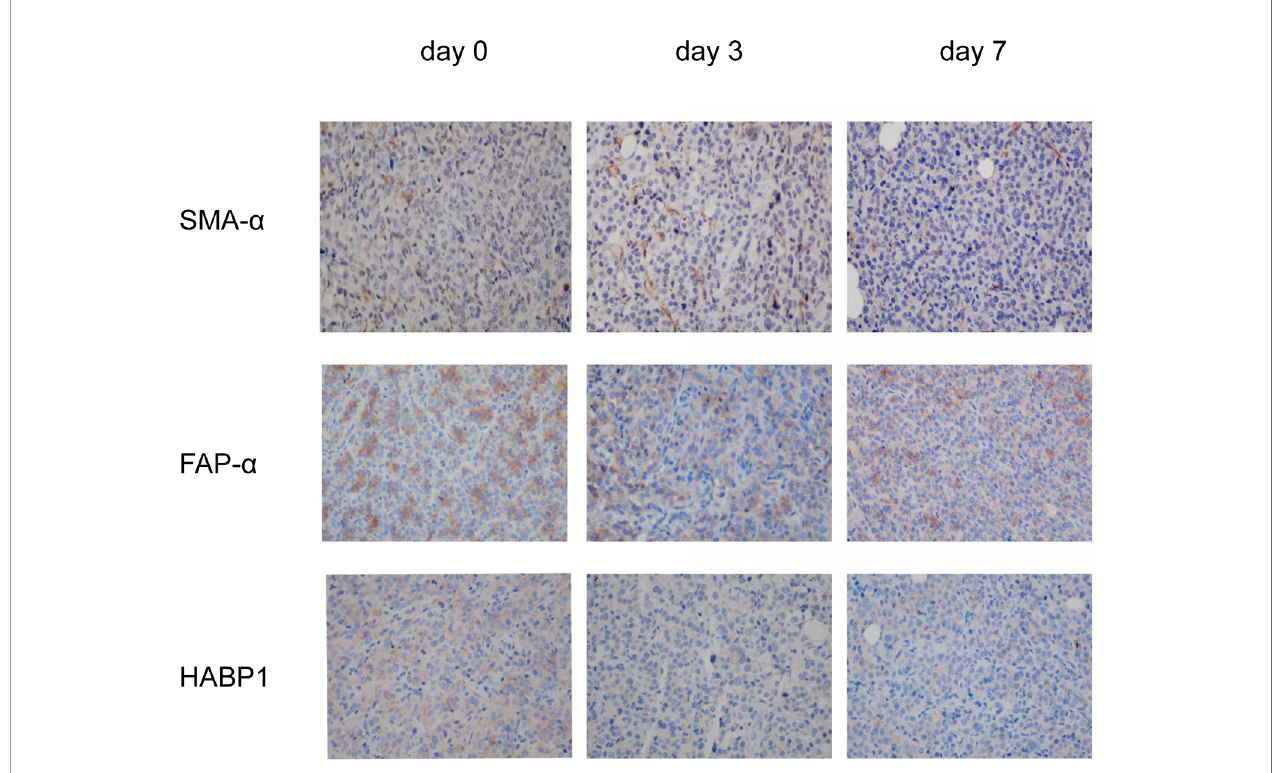
FIGURE 8 | IHC staining of viable tumor region at 3 and 7 days after the initiation of treatment. Representative micrographs of staining for a -SMA, FAP- a , HABP1. Five visual fi elds were randomly captured for each group. Magni fi cation,